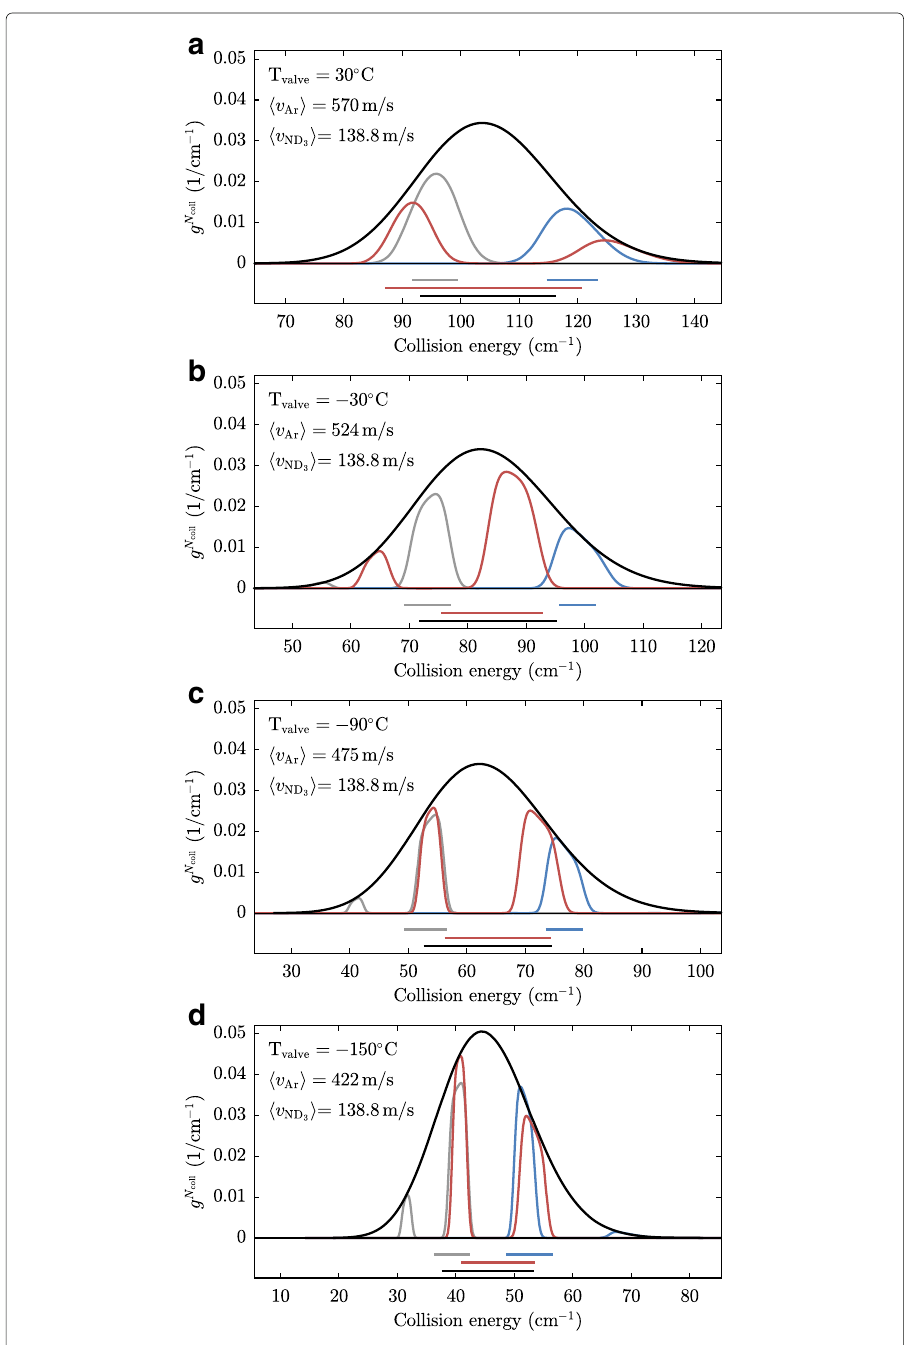
Fig. 15 a - d Same as Fig 14 a - d , but for v ND